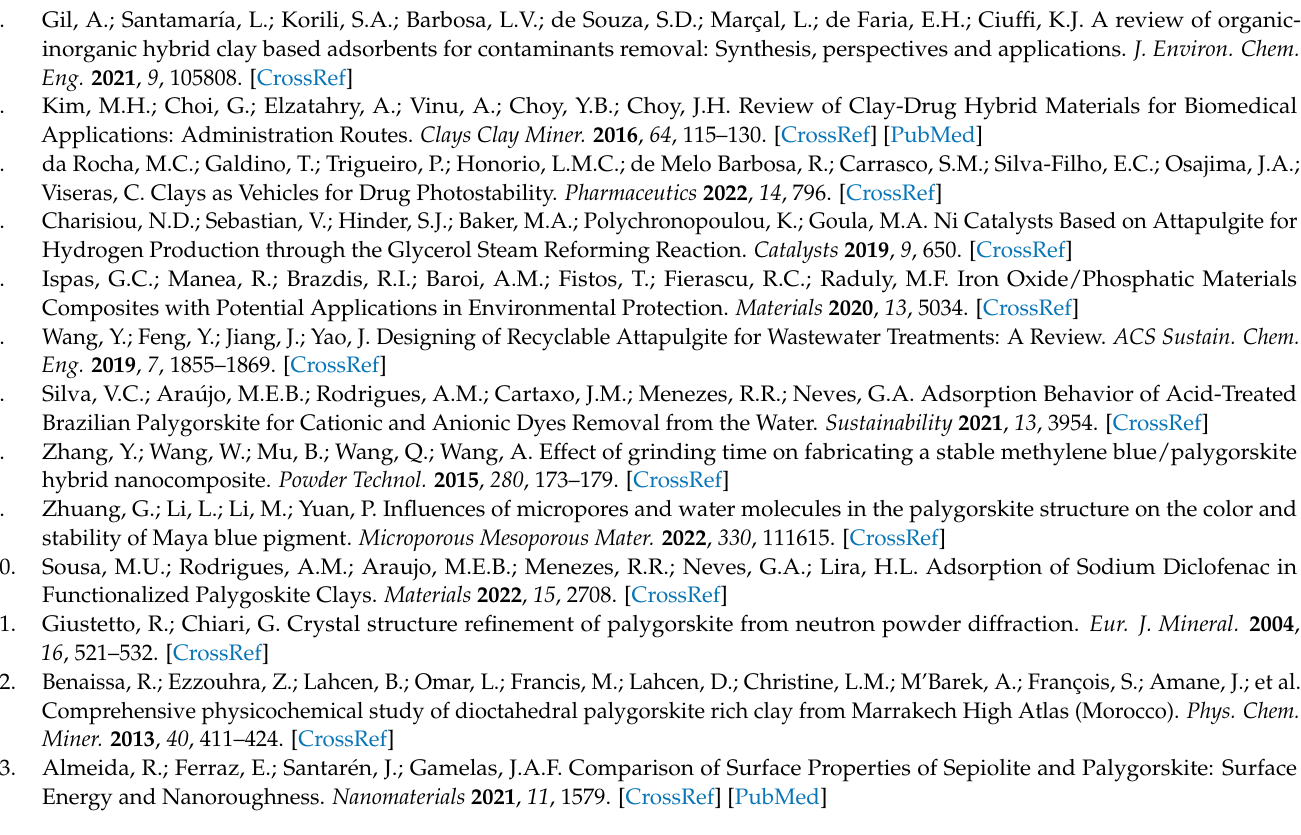
Table S1: The XRD peaks corresponding to the palygorskite structure; Table S2: Color differences for hybrid colored materials, exposed to various environmental